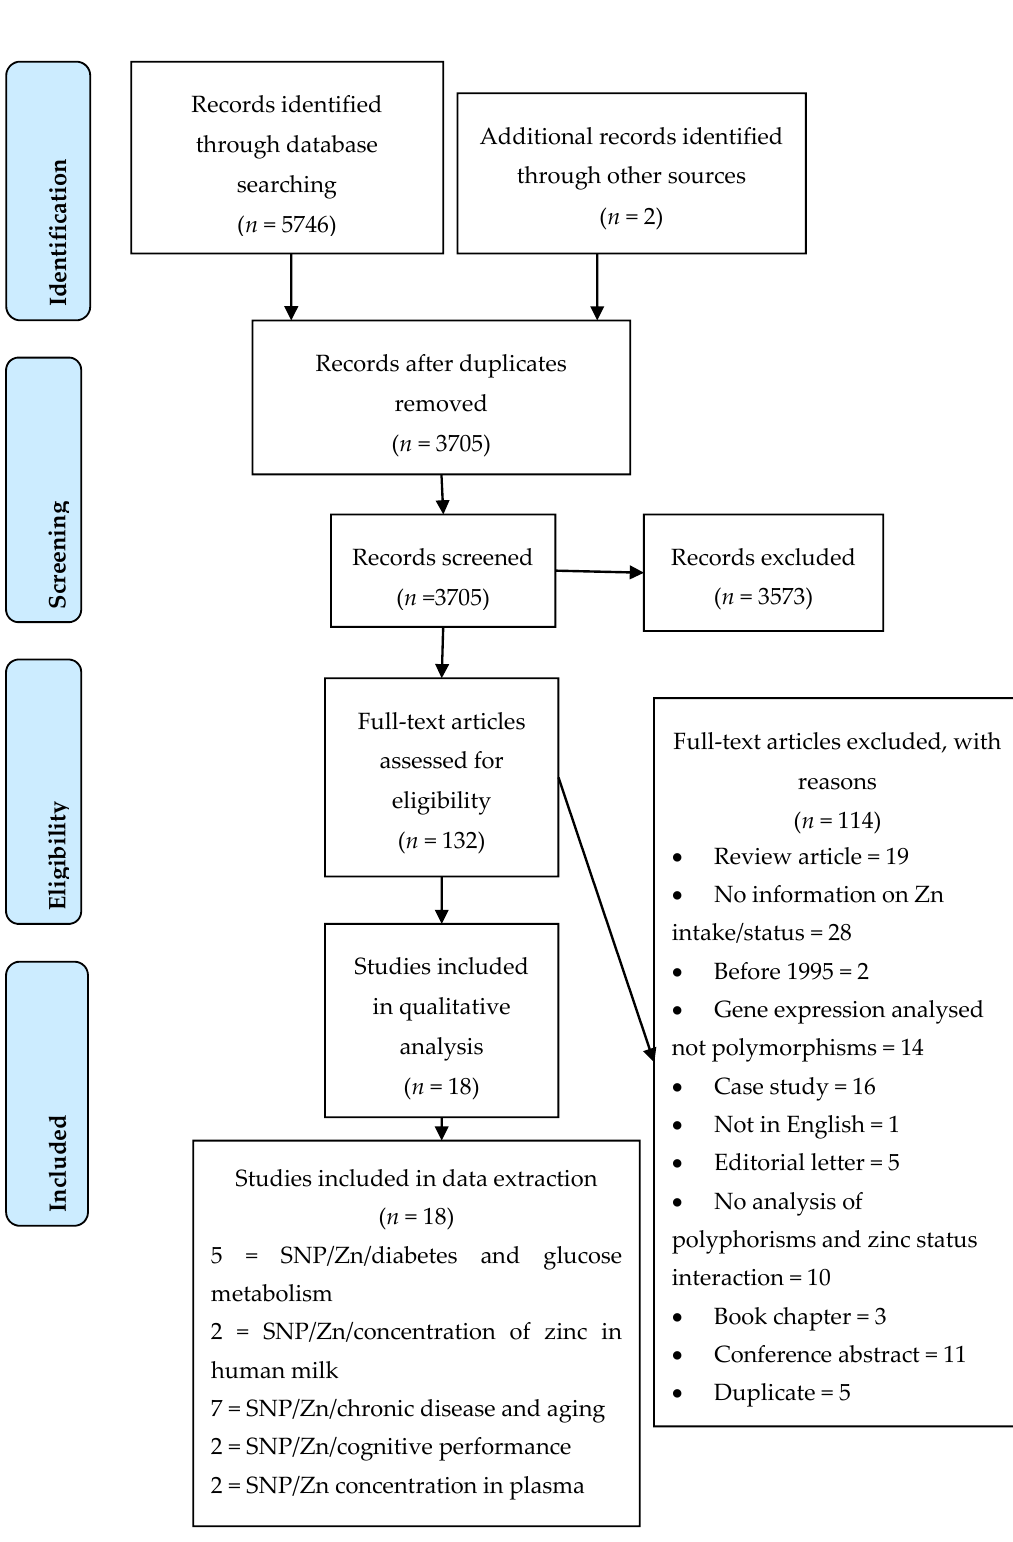
Figure 2 . PRISMA 2009 Flow Diagram adapted from [44]. Figure 2. PRISMA 2009 Flow Diagram adapted from